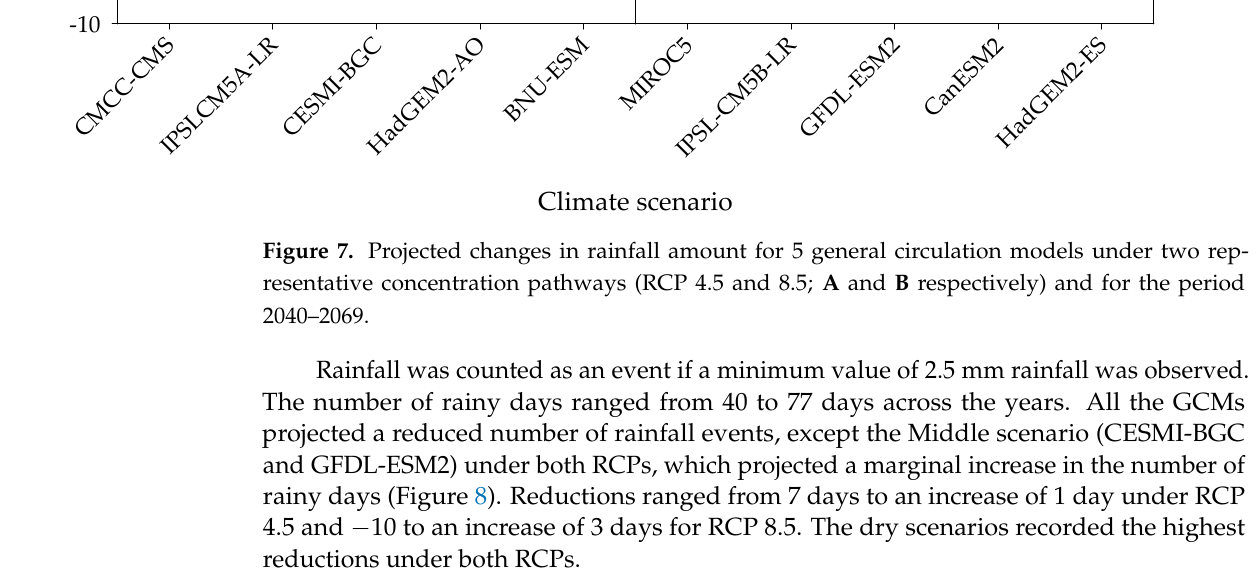
reductions under both RCPs.